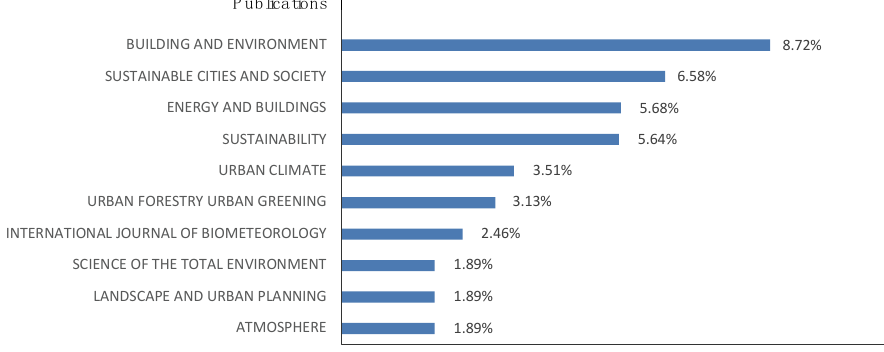
Figure 3. Percentage of urban microclimate papers published in journals (top 10).